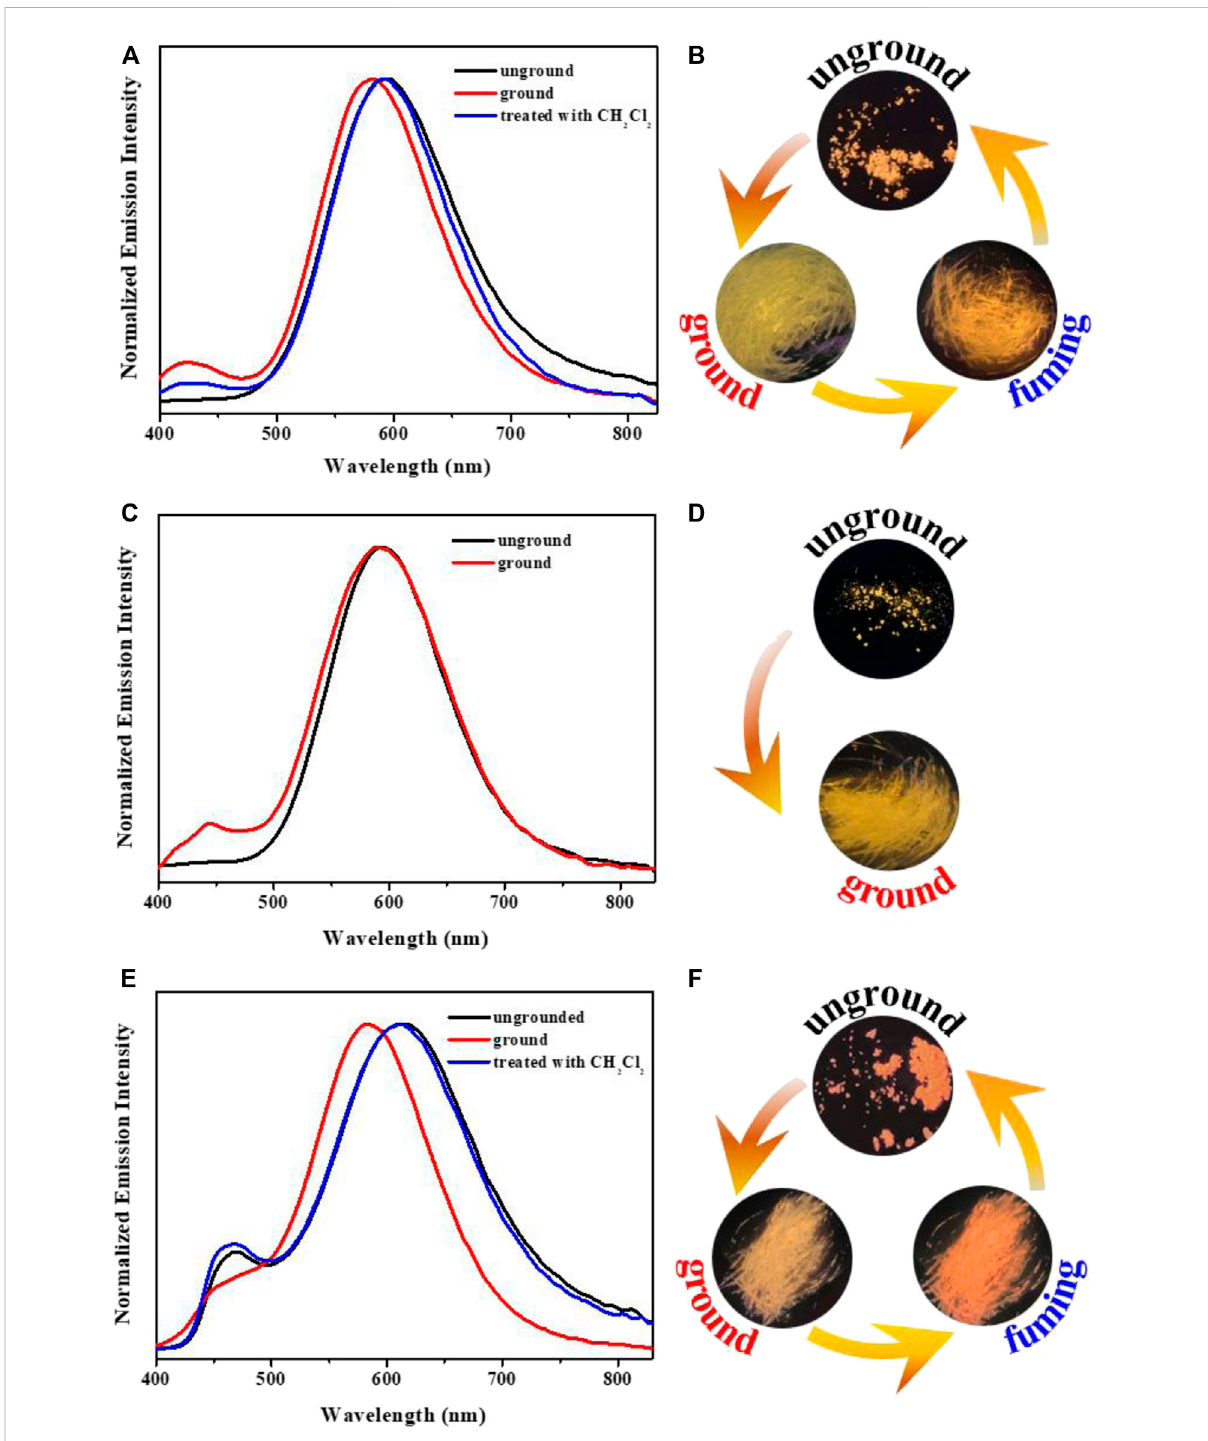
FIGURE 4 Solid-state PL spectra of complexes 1 (A) , 2 (C) , 3 (E) in various solid states; Fluorescence images of 1 (B) , 2 (D) , 3 (F) in different solid